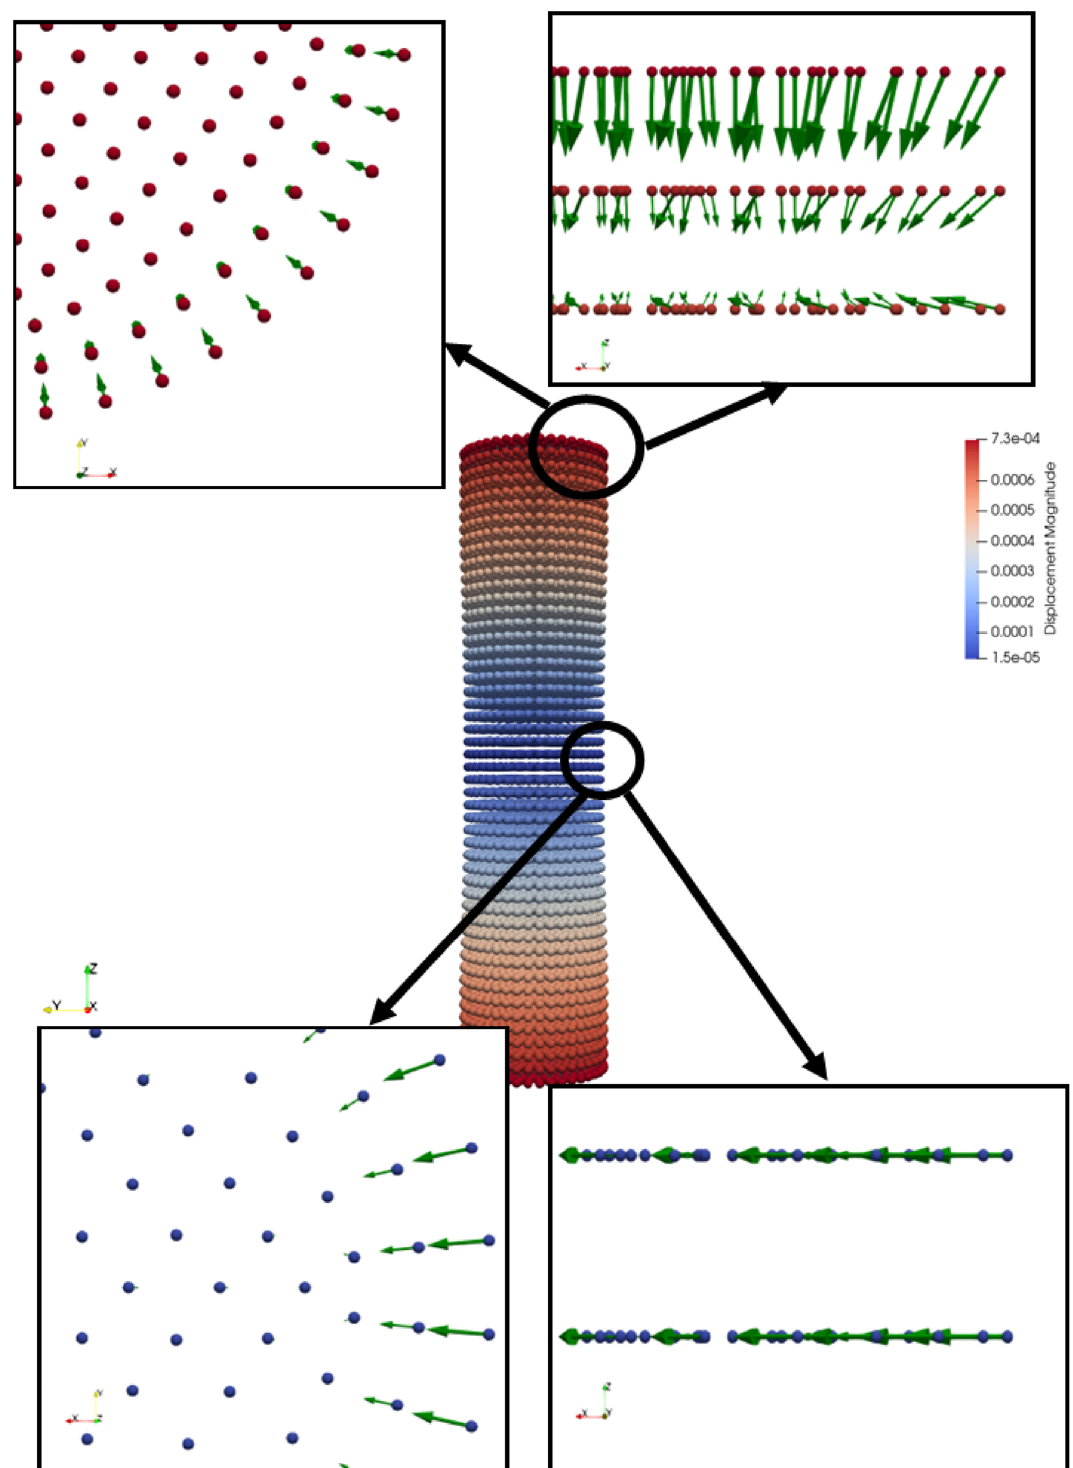
Figure 8. Force density vectors (resultant force per unit volume) at the maximum displacement for fatigue